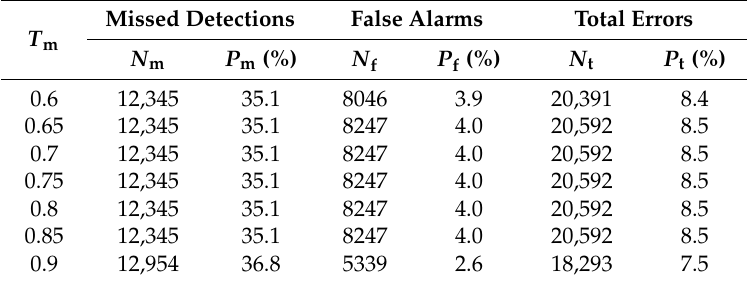
Table 5. Accuracy of CD results produced with different thresholds of data set 2.